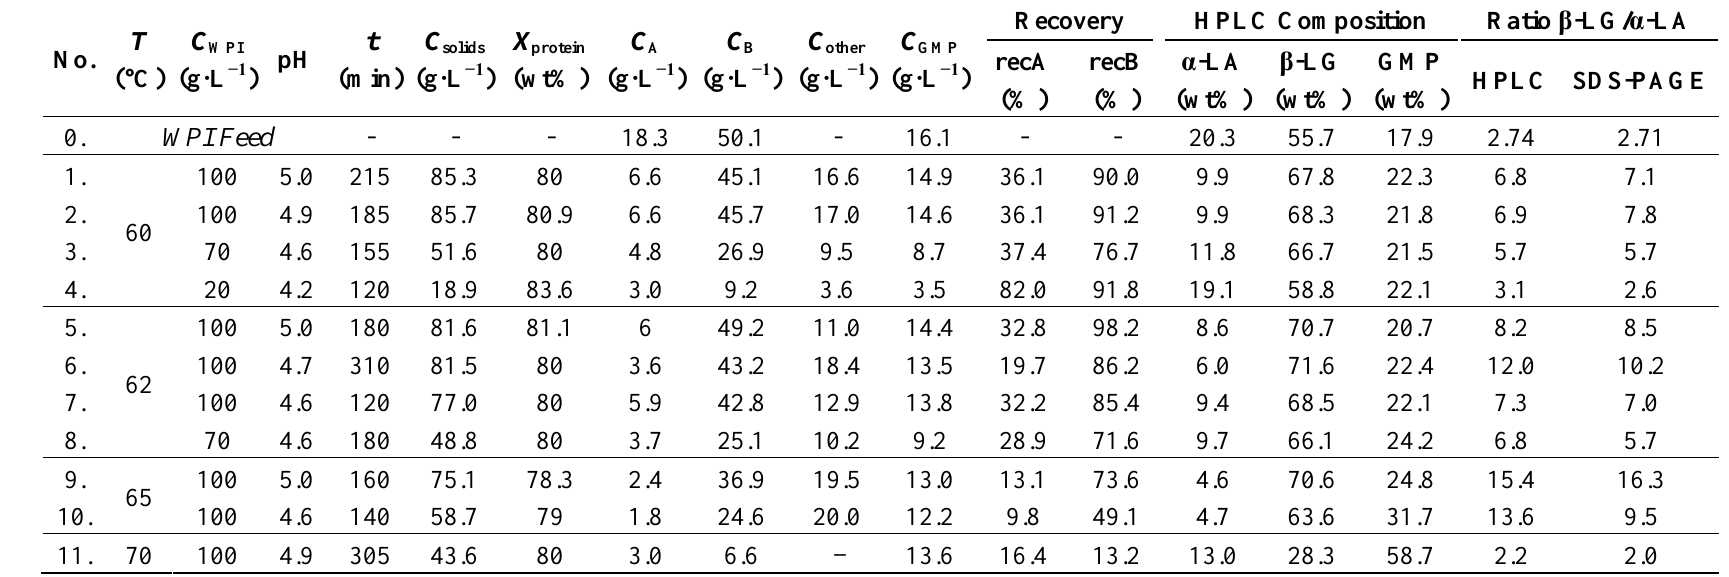
Table 1. HPLC analysis of the compositions of selected soluble (β) fractions after SCO